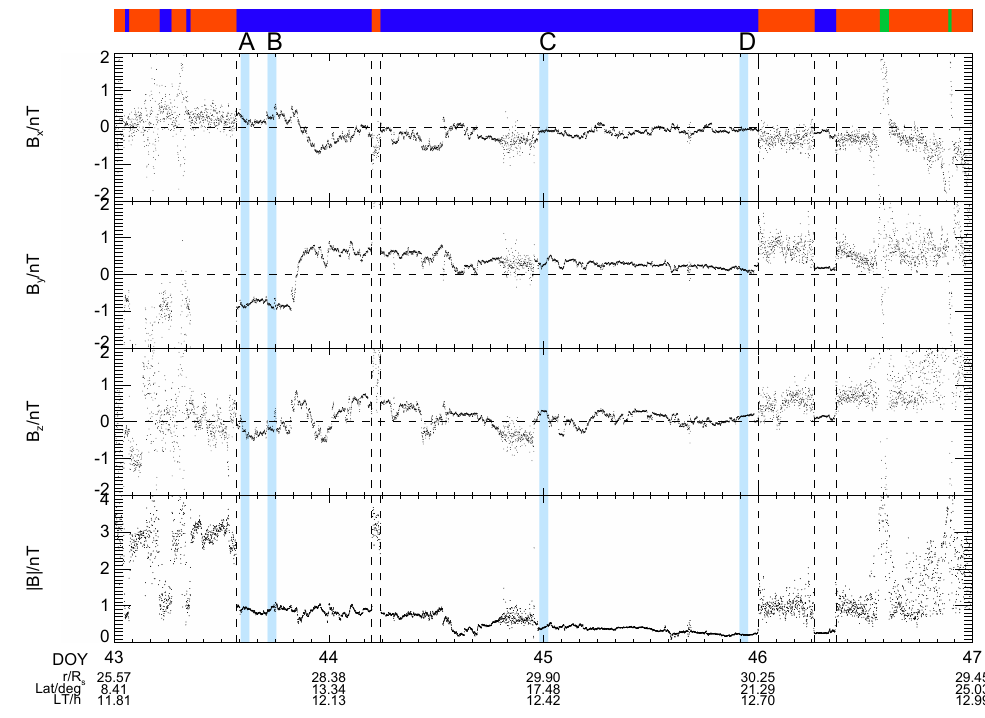
Fig. 2. Magnetic field data for DOY 43 to 46 of 2008, corresponding to the blue trajectory segment spanning apoapsis in Fig. 1. From top to bottom the data panels show the three components of the magnetic field in KSM coordinates, and the field magnitude. In the colour-coded region identifier at the top of the plot green corresponds to the magnetosphere, red to the magnetosheath, and blue to the solar wind. Principal bow shock crossings (red-blue transitions) are identified by vertical black dashed lines. The data at the bottom of the plot give the radial distance ( R S ) , latitude (deg), and local time (h) of the spacecraft. The blue vertical stripes labelled “A” to “D” correspond to the suitably lagged times of four HST imaging